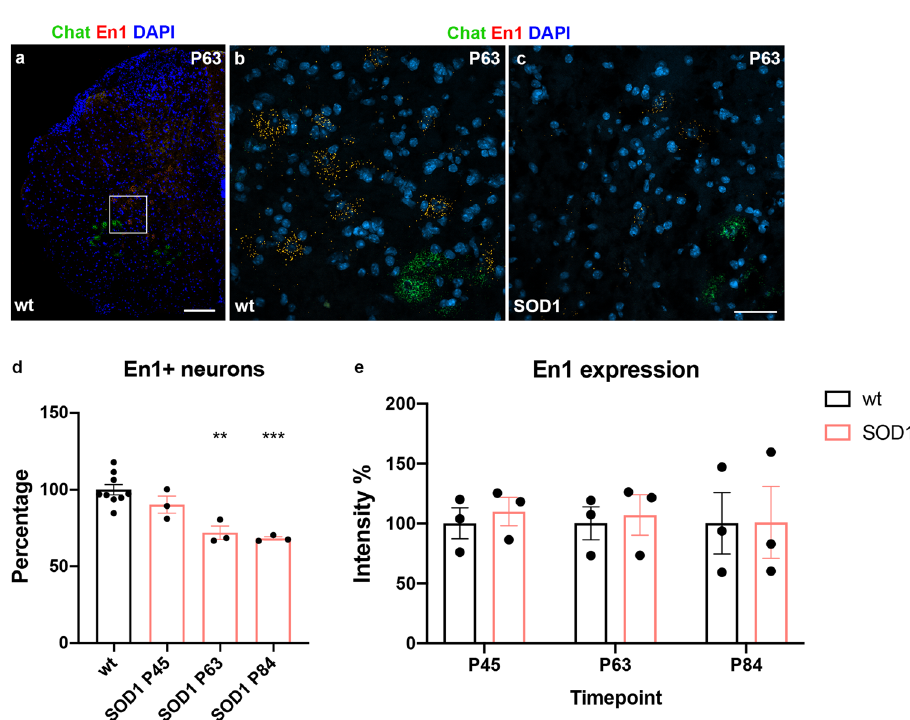
Fig. 4 En1 positive neuron reduction from postnatal day 63 in the SOD1 G93A mouse. a Microphotograph of a wild-type mouse hemicord after RNAscope in situ hybridization at postnatal day 63. Chat in green, En1 in orange and DAPI in blue. b Magni fi cation of Chat and En1 expression in control conditions and c at P63 in a SOD1 G93A mouse. d Quanti fi cations of En1 positive neurons in control conditions versus postnatal day 45, 63, and 84 in the ALS mouse model. There was a reduction at P63 to about 75% and to about 68% at P84 compared to age-matching wild-types (one-way ANOVA and Dunnett ’ s post hoc, F (3, 14) = 13.45, P45 P = 0.3108, P63 P = 0.0010, P84 P = 0.0003; wt N = 9, SOD1 G93A N = 3 mice per timepoint). e Intensity-measurements of En1 positive dots present within the quanti fi ed neurons showed no differences among the different timepoints, indicating that En1 neurons still present in the SOD1 G93A mouse do not show lower transcript expression at these than earlier timepoints (two-way ANOVA and Tukey ’ s multiple comparisons test, F (2, 12) = 0.02754, P45 P = 0.9990, P63 P = 0.9998, P84 P = 1; N = 3 independent mice per condition per timepoint). Scale bar in ( a ) = 200 μ m, scale bar in ( c ) = 50 μ m representative also for ( b ). A minimum of 60 pictures (as shown in ( b – c )) was quanti fi ed per condition. In all graphs, data are presented as mean values ± SEM. Source data are provided as a Source Data fi